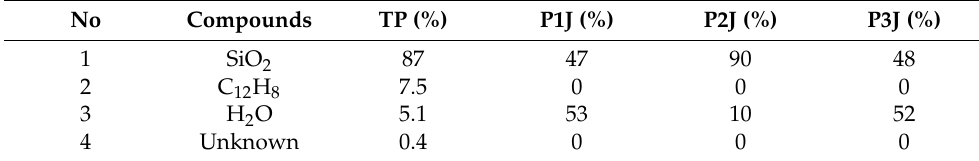
Table 2. Percentage of compound changes in fiber.